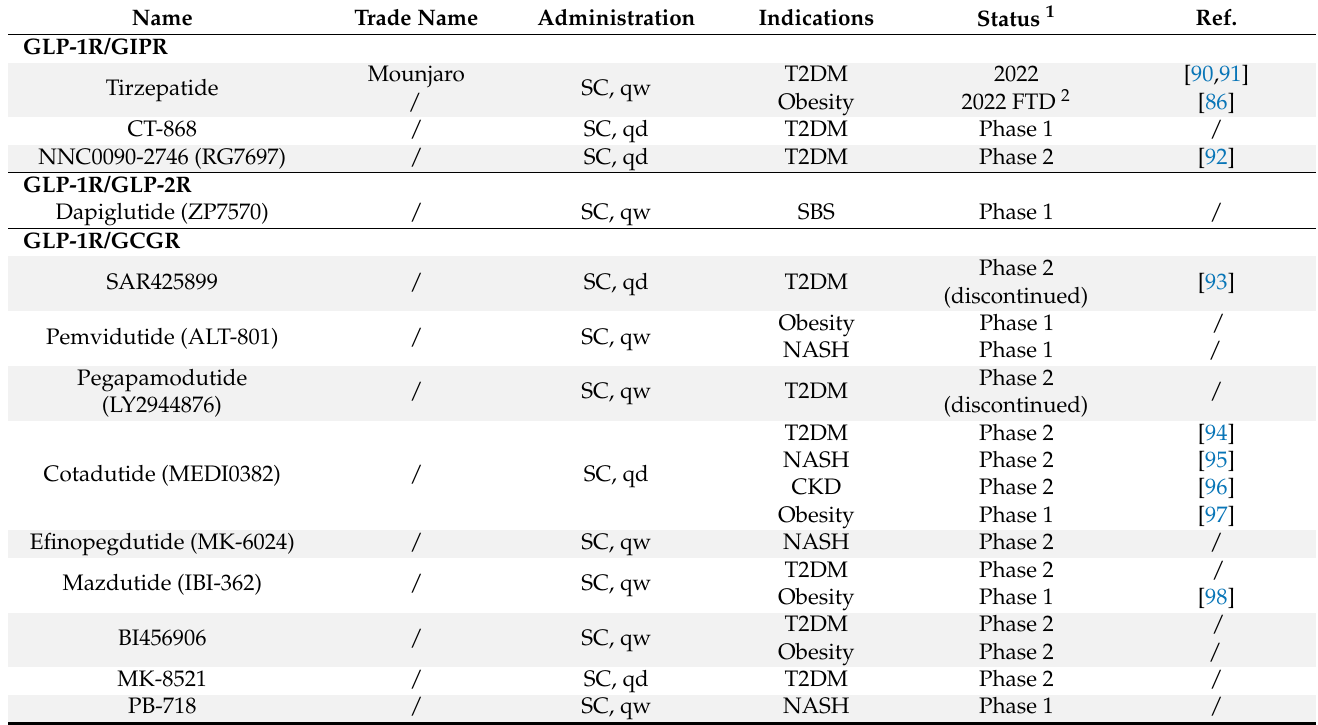
Table 2. Dual/triple-agonists targeting GLP-1R and other